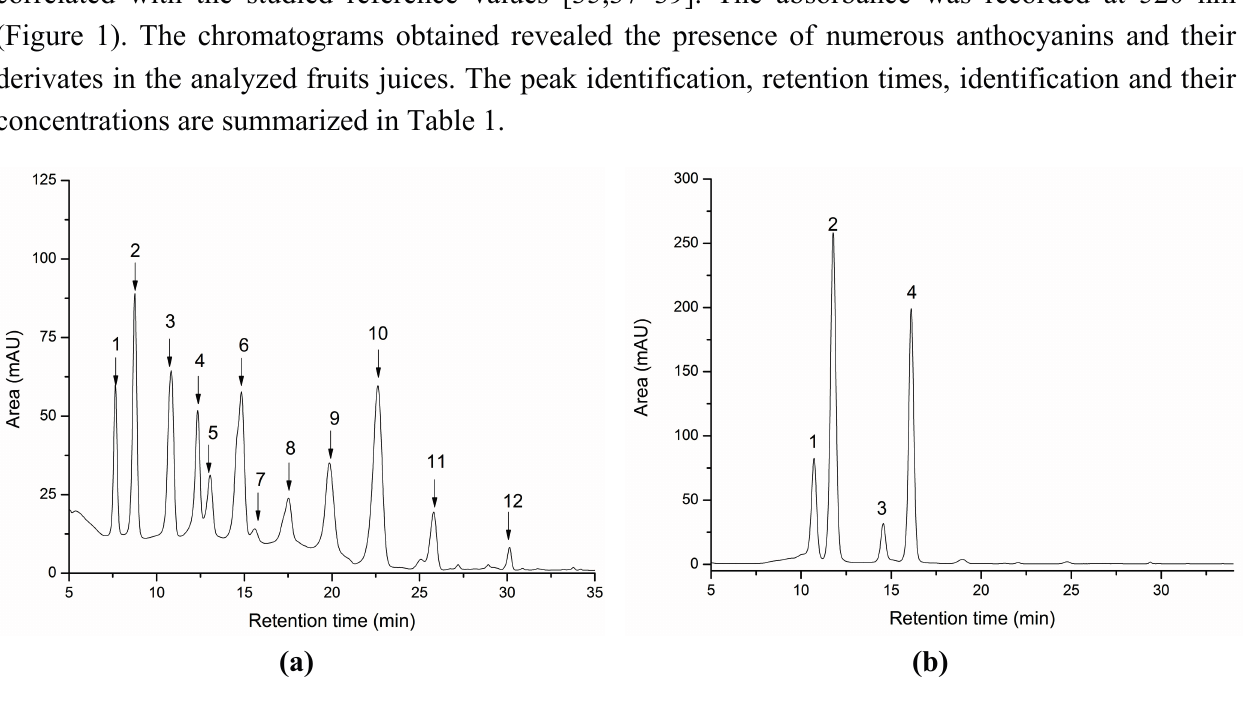
Figure 1. HPLC chromatograms of ( a ) blueberry Vaccinum sp., and ( b ) blackcurrant Ribes nigrum juices (Peaks assignments are shown in Table